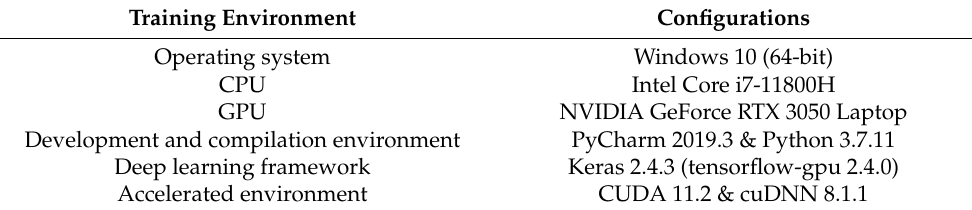
Table 2. The model training environment and parameters